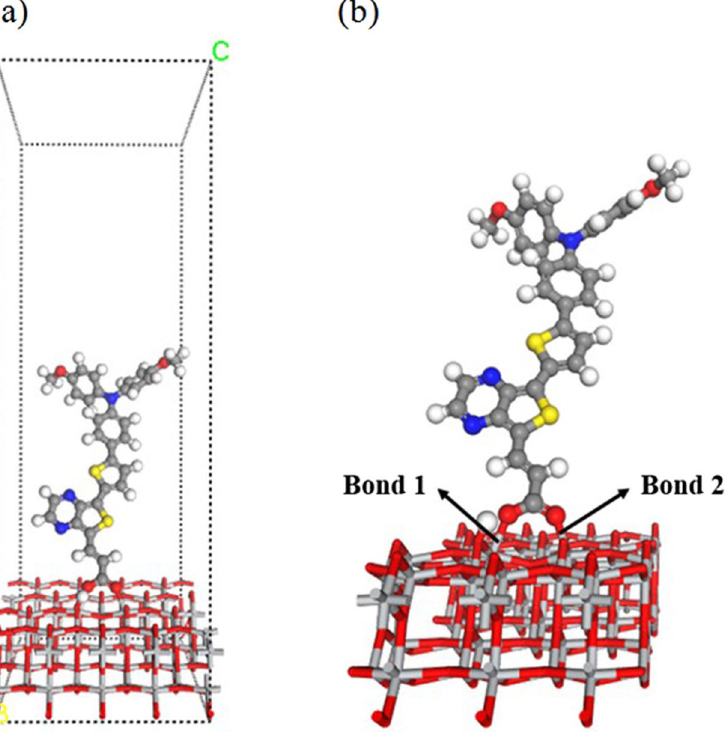
Figure 8. The optimized geometry of designed full dye (D π -TP-COOH) adsorbed onto TiO 2 anatase (101) surface with the bidentate bridging mode.